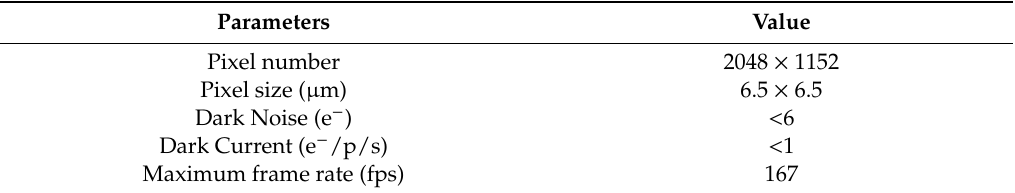
Table 2. The parameters of GSENSE2011